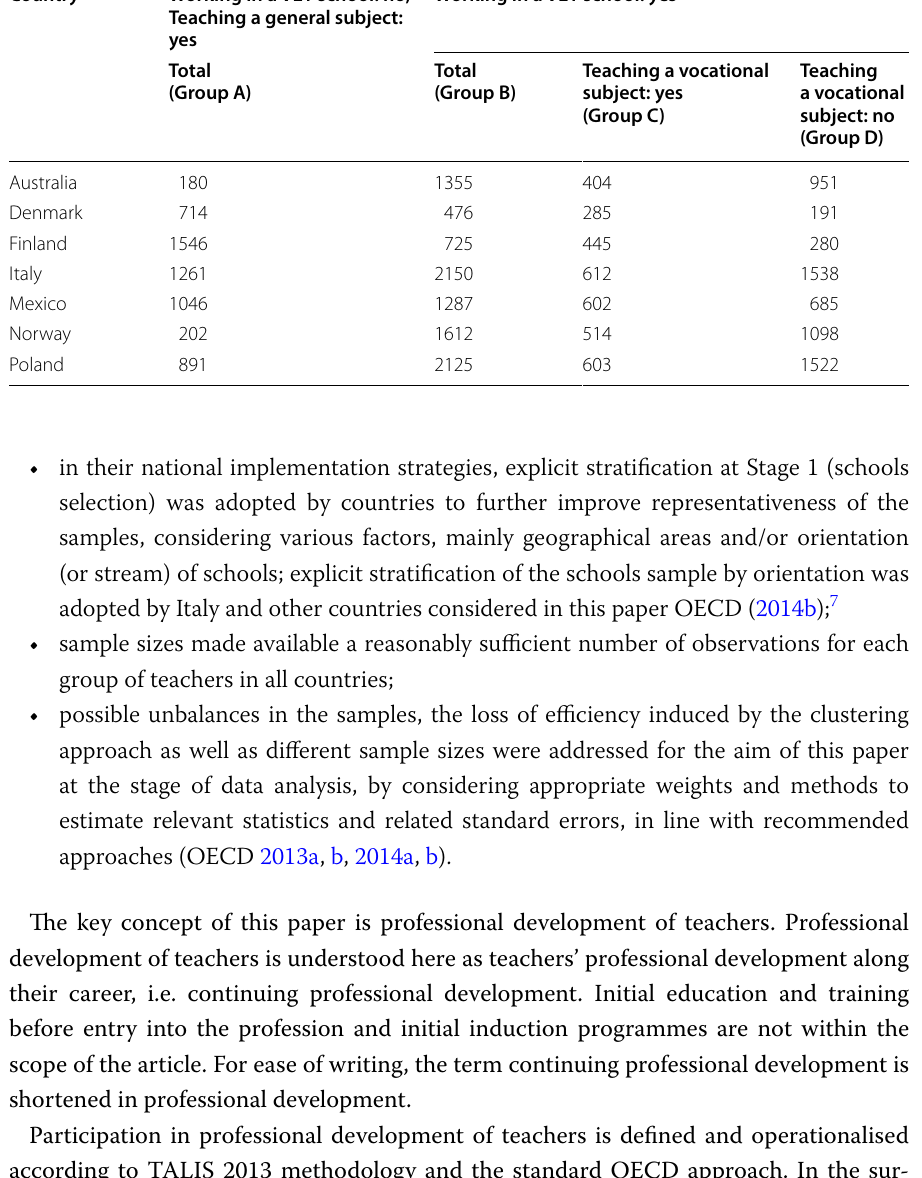
Table 1 TALIS 2013-ISCED level 3: structure of the sample used in the analysis (upper secondary teachers in absolute numbers) (Source: Author’s calculations based on TALIS 2013, ISCED 3)